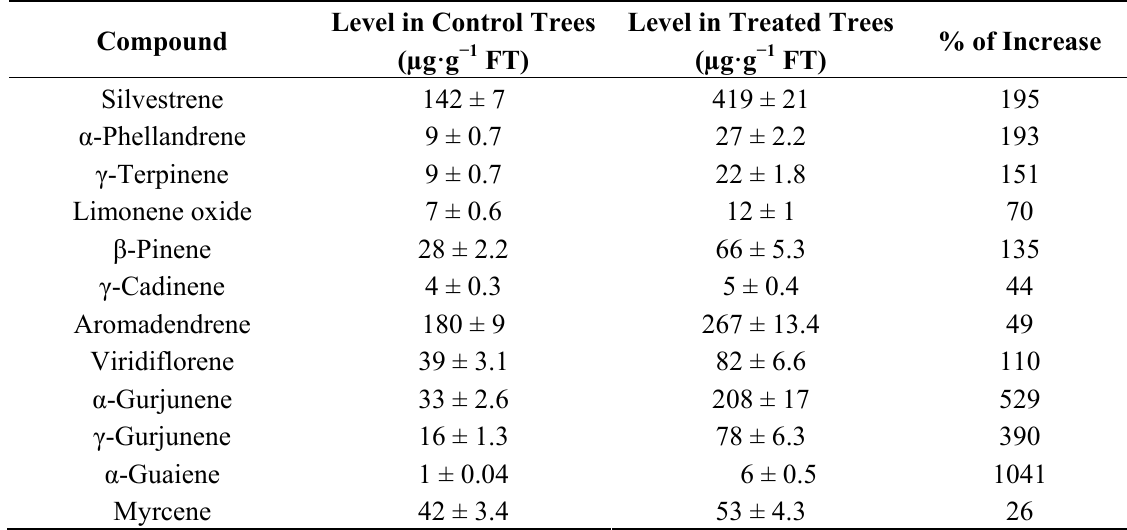
Table 2. Level of terpenoids that increased in leaves of Eucalyptus trees treated with OC kappa.